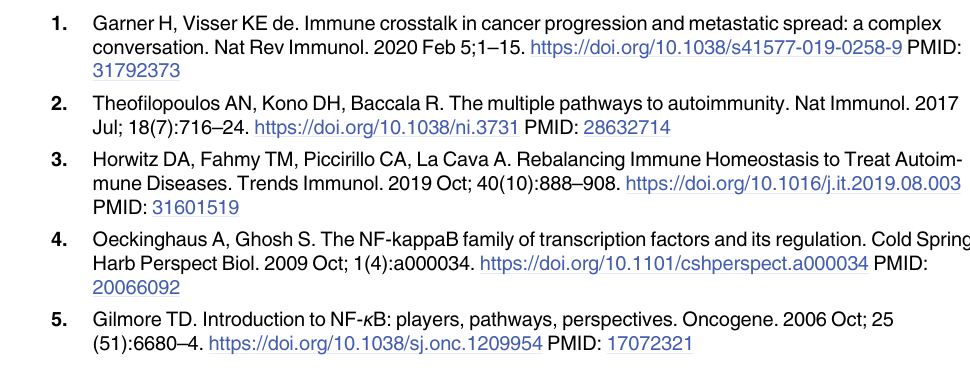
S3 Fig. Average number of active degradation sites in simulations over time. Average num- ber of autophagosome simulation sites over time in selected simulation configurations with low, moderate, and high values of p . The black outlined graphs correspond to the config- degrade urations shown in Fig 5